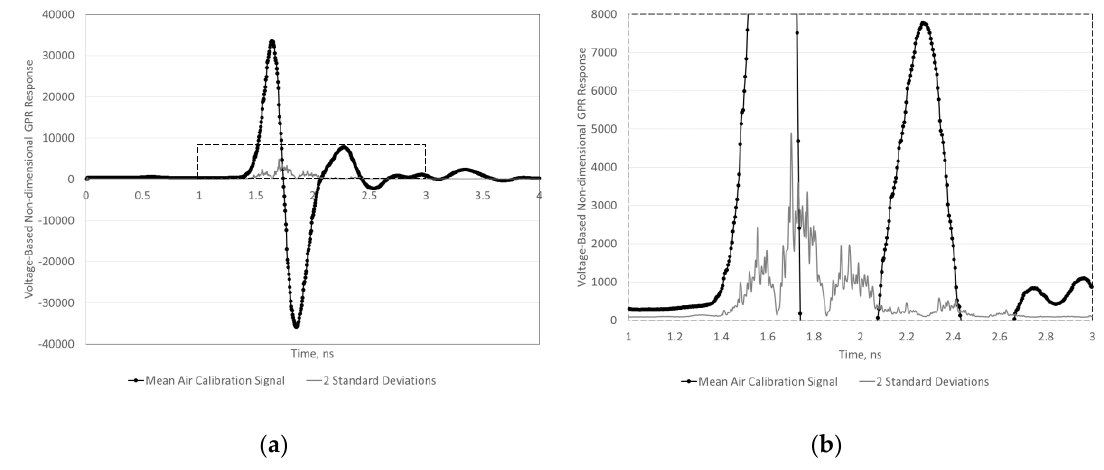
Figure 4. Variability of the signal with respect to direct coupling shown by air calibration scan mean and 2 standard deviations: ( a ) zoomed out and ( b ) zoomed in on the section bordered with a gray dotted line in Figure 4a with a clearer view of the 2 standard deviation variations.